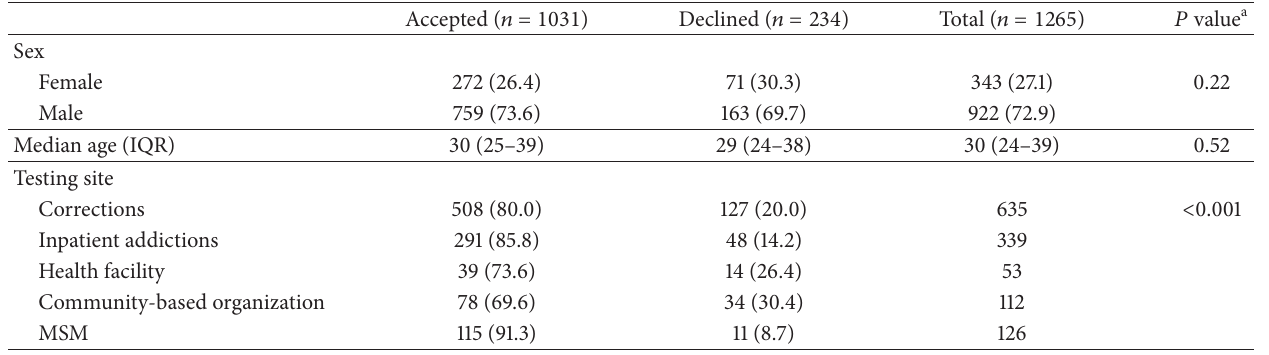
Table 1: Characteristics of participants offered syphilis and/or HIV POC testing ( 𝑁 = 1, 265 ).